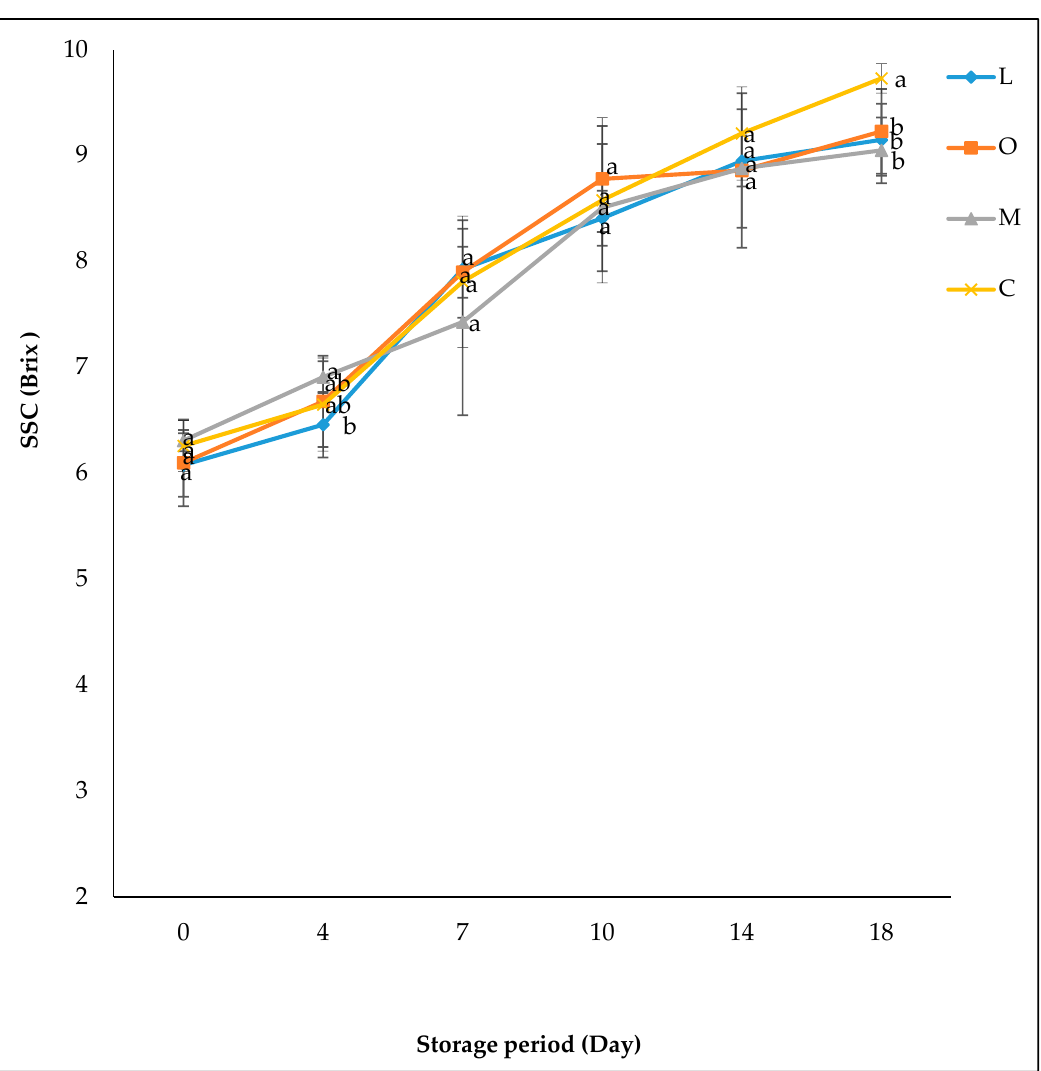
Figure 5. Effect of different essential oil emulsions (L = lemon, O = orange, and M = mandarin essential oil) on soluble solid content (SSC) of strawberry fruits stored at 2 °C for 18 days. Vertical bars indicate the standard deviation (n = 6). Means and different letters indicate significant difference between treated and control fruits at each storage period (Duncan’s of 95%).